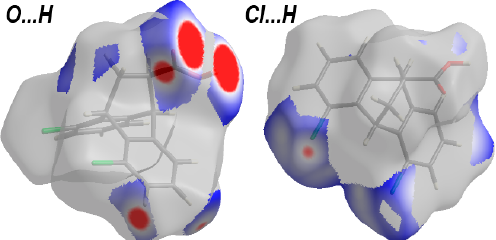
Figure 6. Decomposed d norm maps of the important interactions in 5 .